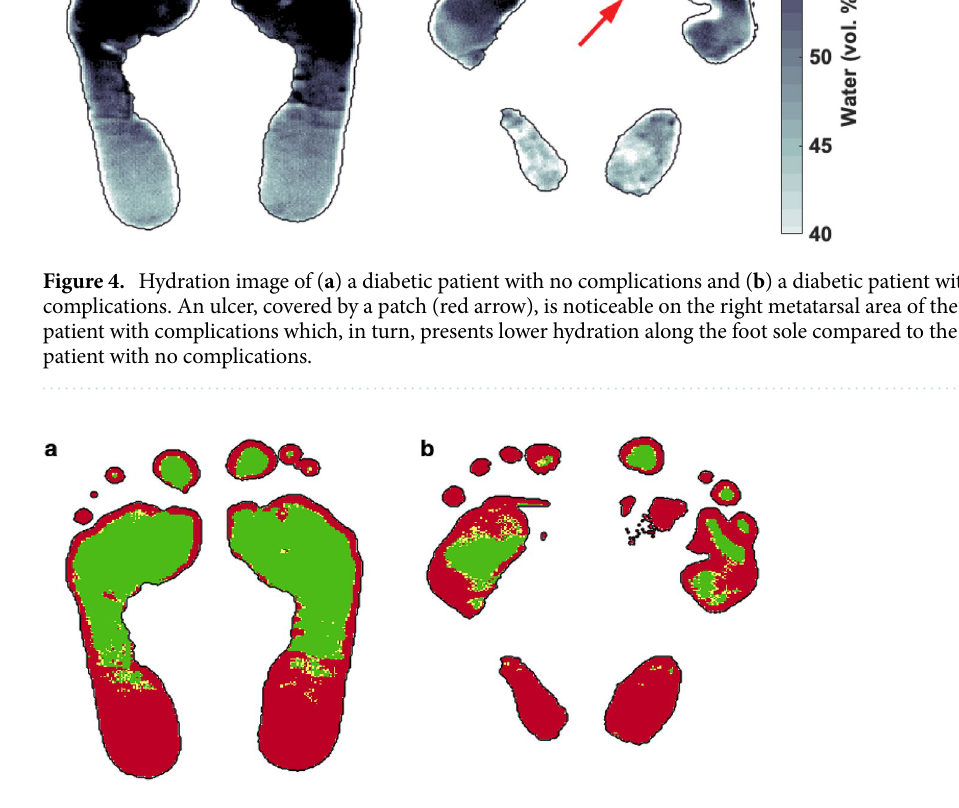
Figure 5. RYG images of ( a ) a diabetic with no complications and ( b ) a diabetic patient with complications. Red pixels, colored for hydration values below 51.7%, potentially indicate high deterioration risk. Green pixels, colored for hydration above 52.9%, are expected to have lower ulceration risk. Yellow pixels are colored for hydration values in between. Diabetic patients with complications present more red areas than the diabetics with no